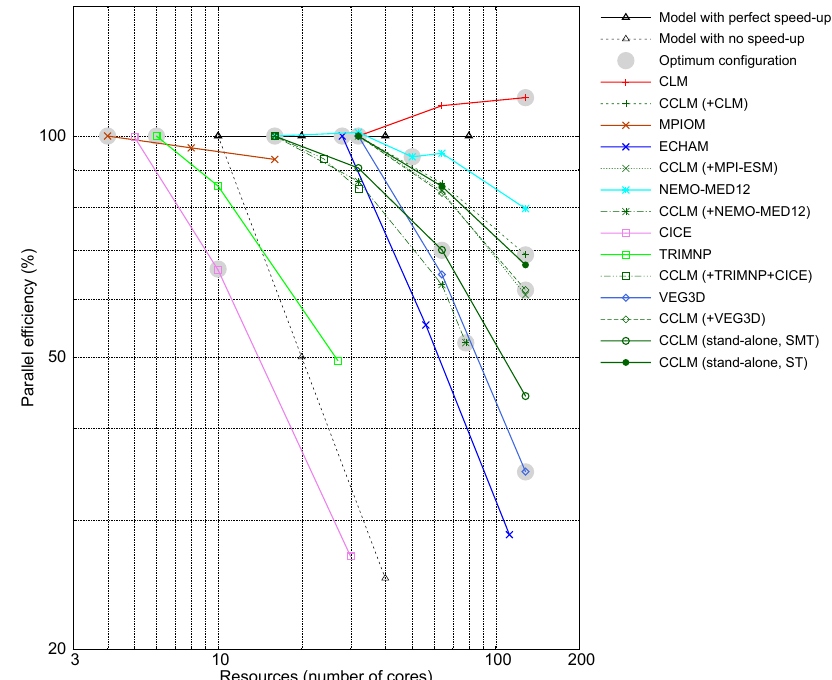
Figure 5. As Fig. 3 but for the parallel efficiency of the components in % of the reference